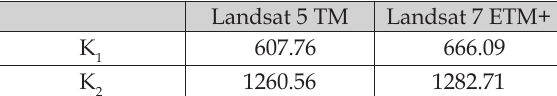
Table 2. Landsat TM and ETM+ Thermal Band Cali - bration Constants.